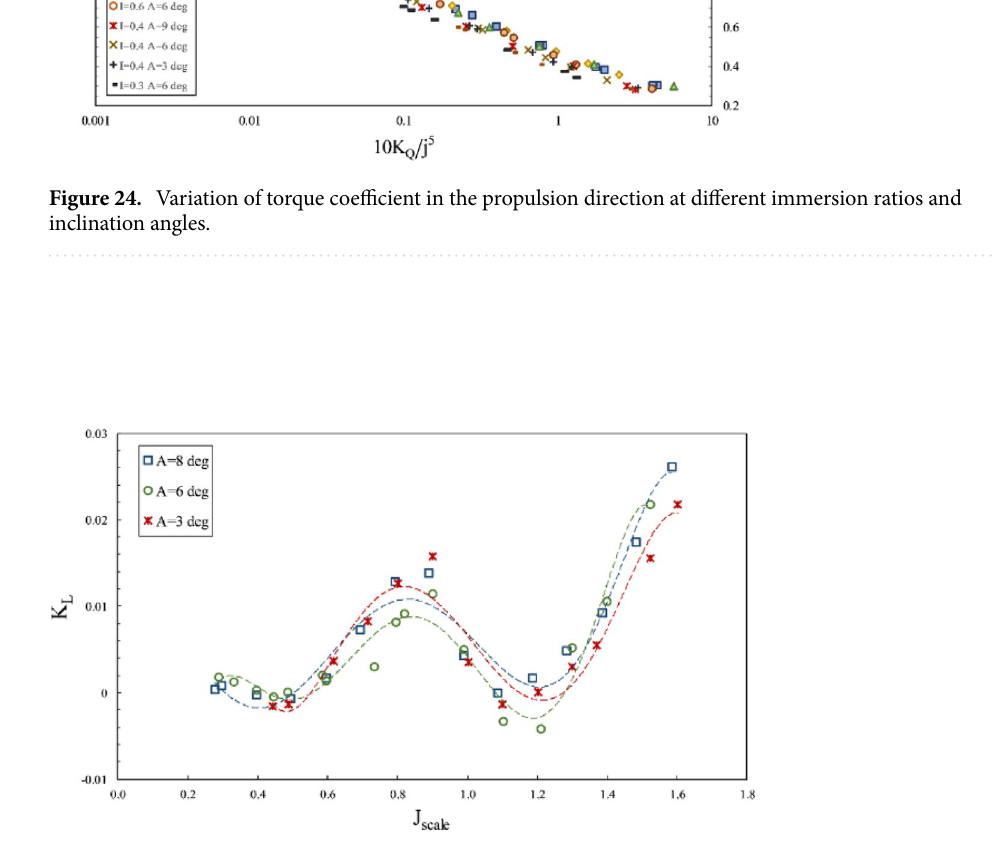
Figure 25. Lift coefficient on propeller direction in different inclination angles ( I = 0.4